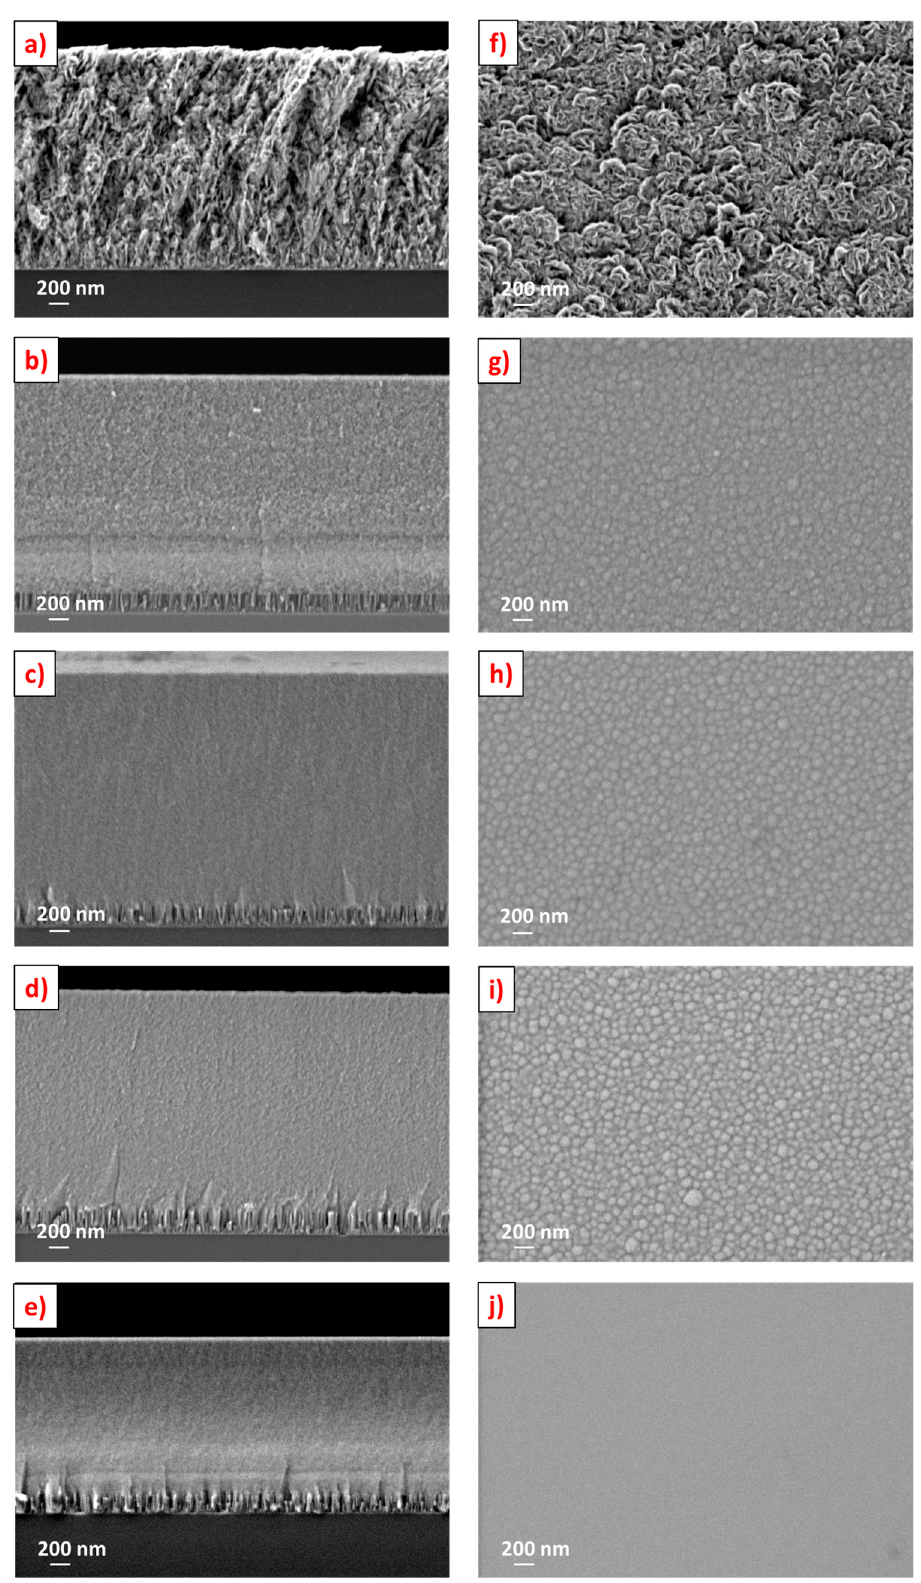
Figure 2. Scanning electron microscopy micrographs of the cross-section morphologies: ( a ) Pure MoSe 2 , ( b ) RF170, ( c ) RF270, ( d ) RF340, ( e ) RF270(50V) and their respective top surface morphologies: ( f ) Pure MoSe 2 , ( g ) RF170, ( h ) RF270, ( i ) RF340, ( j ) RF270(50V)